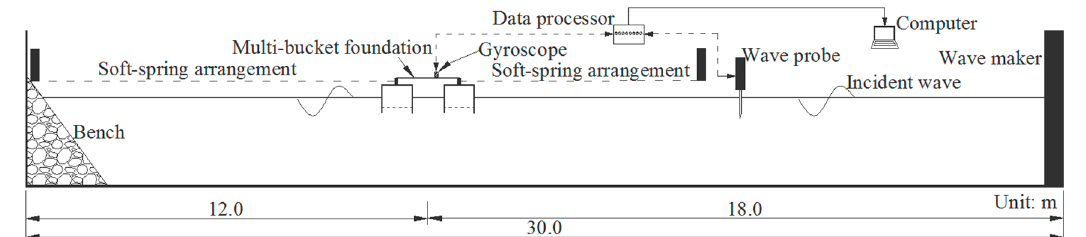
Figure 8. Sketch of the experiment setup for the multi-bucket foundation.